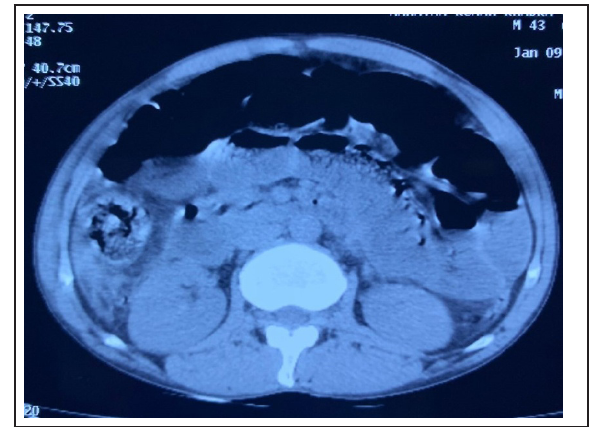
Figure 2. Contrast enhanced computed tomography of abdomen shows enlarged head, body with indistinct margin, normal enhancement and peritoneal